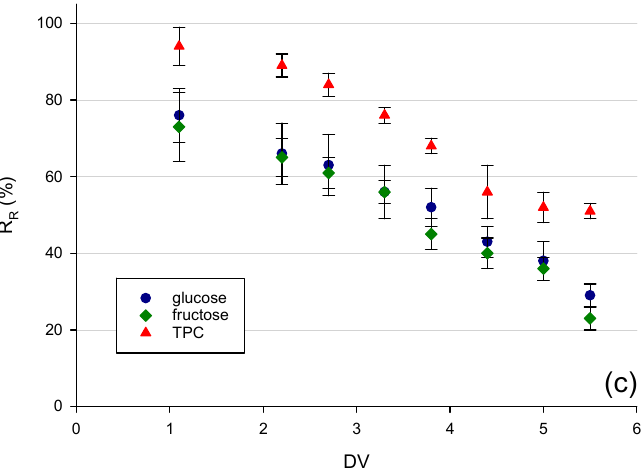
Figure 4. Recovery rate of total phenolic compounds, glucose, and fructose in the retentate stream during diafiltration with ( a ) TS40 ( b ) NP030 and ( c ) XN45 membranes.